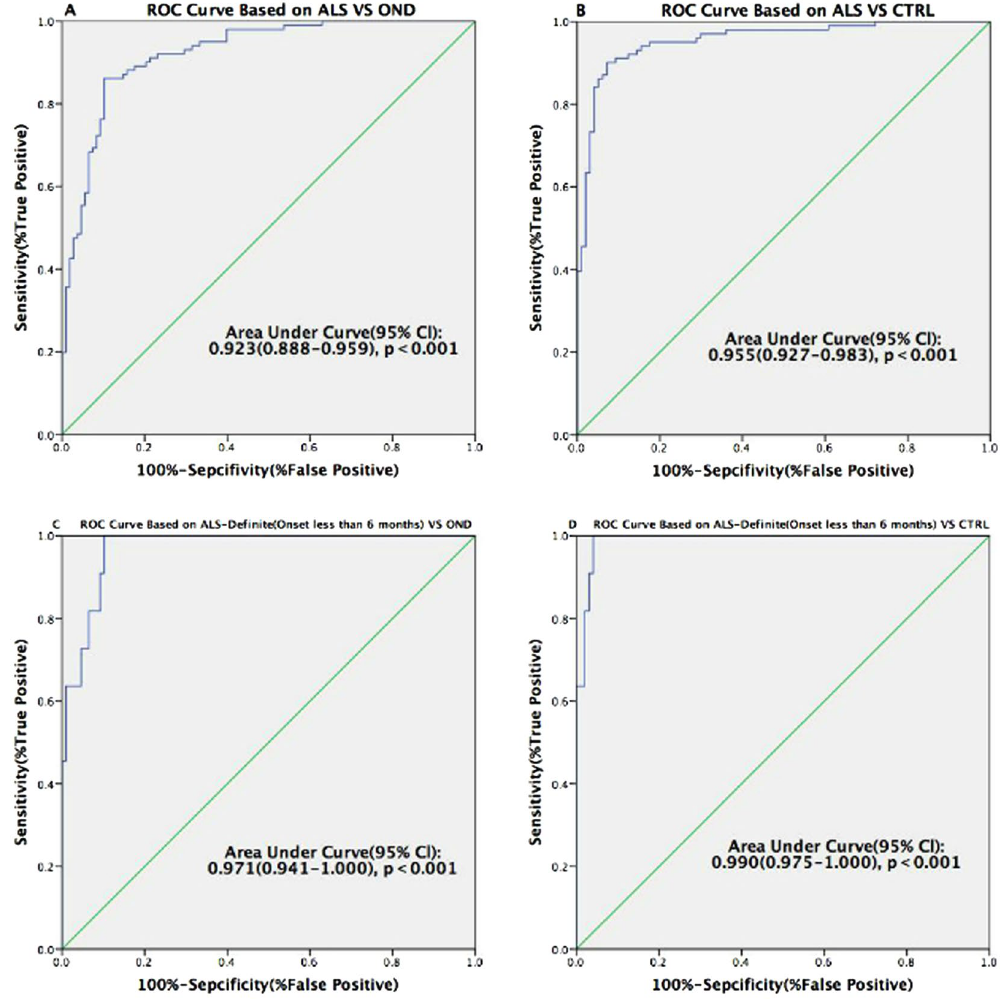
Figure 2. Receiver Operating Characteristic curves for distinguishing ALS/ALS-definite patients (onset less than 6 months) from OND and CTRL. ( A ) ALS was distinguished from OND with 6.6945 (ng p75 ECD /mg creatinine) as the cuff-off value; ( B ) ALS was distinguished from CTRL with 5.1221 (ng p75 ECD /mg creatinine) as the cut off value. ( C ) ALS-definite patients less than 6 months were distinguished from OND with 7.2015 (ng p75 ECD /mg creatinine) as the cut-off value; ( D ) ALS-definite patients less than 6 months were distinguished from CTRL with 6.827 (ng p75 ECD /mg creatinine) as the cut off